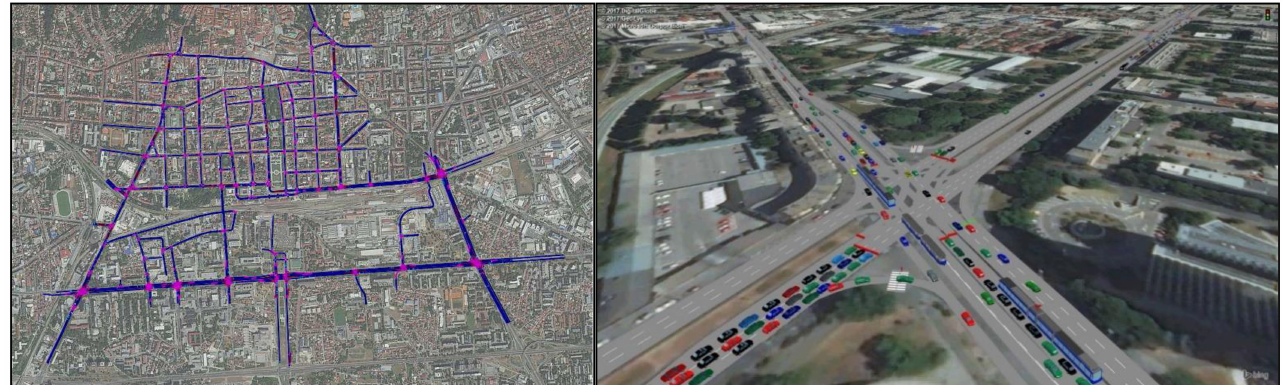
Figure 6. Microsimulation model of the study area in